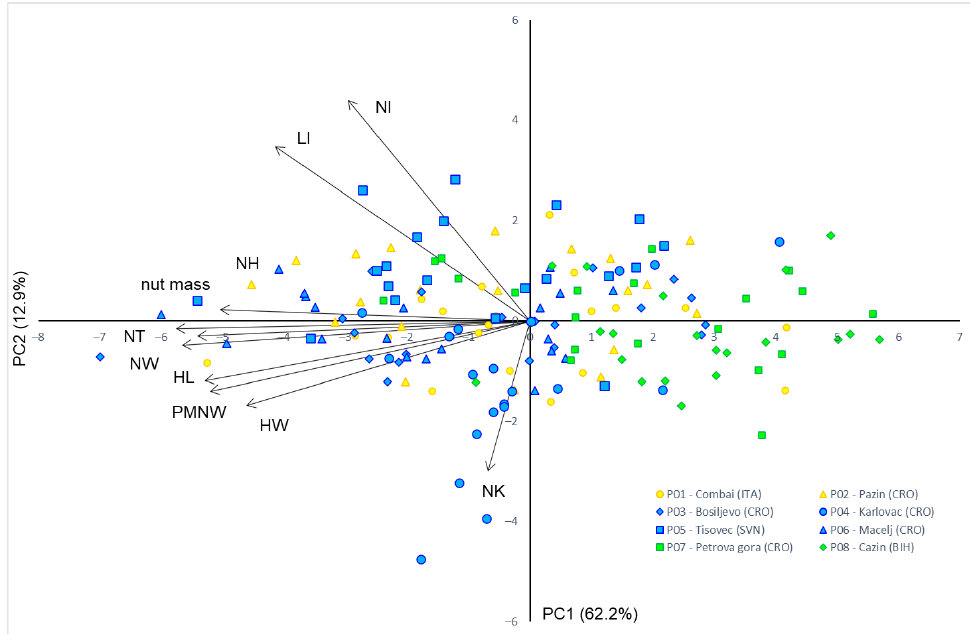
Figure 1. Principal component (PC) analysis of eight sweet chestnut populations based on ten morphological traits. The color of the signs is related to the biogeographical region and management type: yellow color — sub-Mediterranean high-forest populations; blue color — continental high-forest populations; and green color — continental coppice populations. Morphometric traits: nut height (NH); nut width (NW); distance from nut base to the point of maximum nut width (PMNW); nut thickness (NT); hilum length (HL); hilum width (HW); number of kernels (NK); number of intrusions of the seed coat into the kernel (NI); length of the longest intrusion of the seed coat into the kernel (LI).